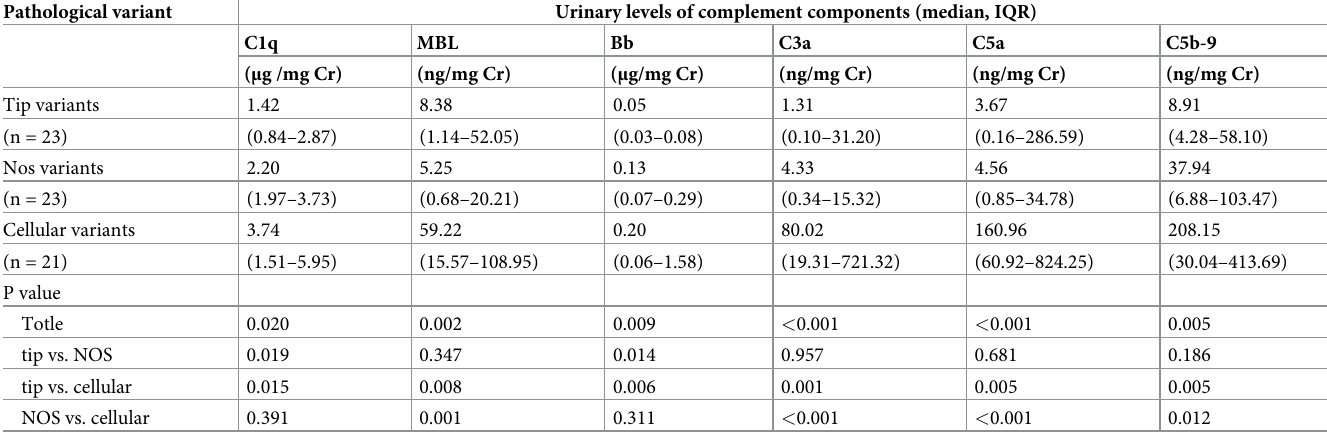
Table 3. Urinary levels of complement components in different pathological variants of primary FSGS patients. Pathological